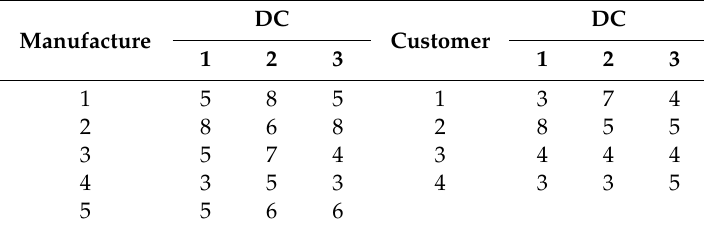
Table 7. Unit shipping cost for each stage (US$) in Experiment 2.